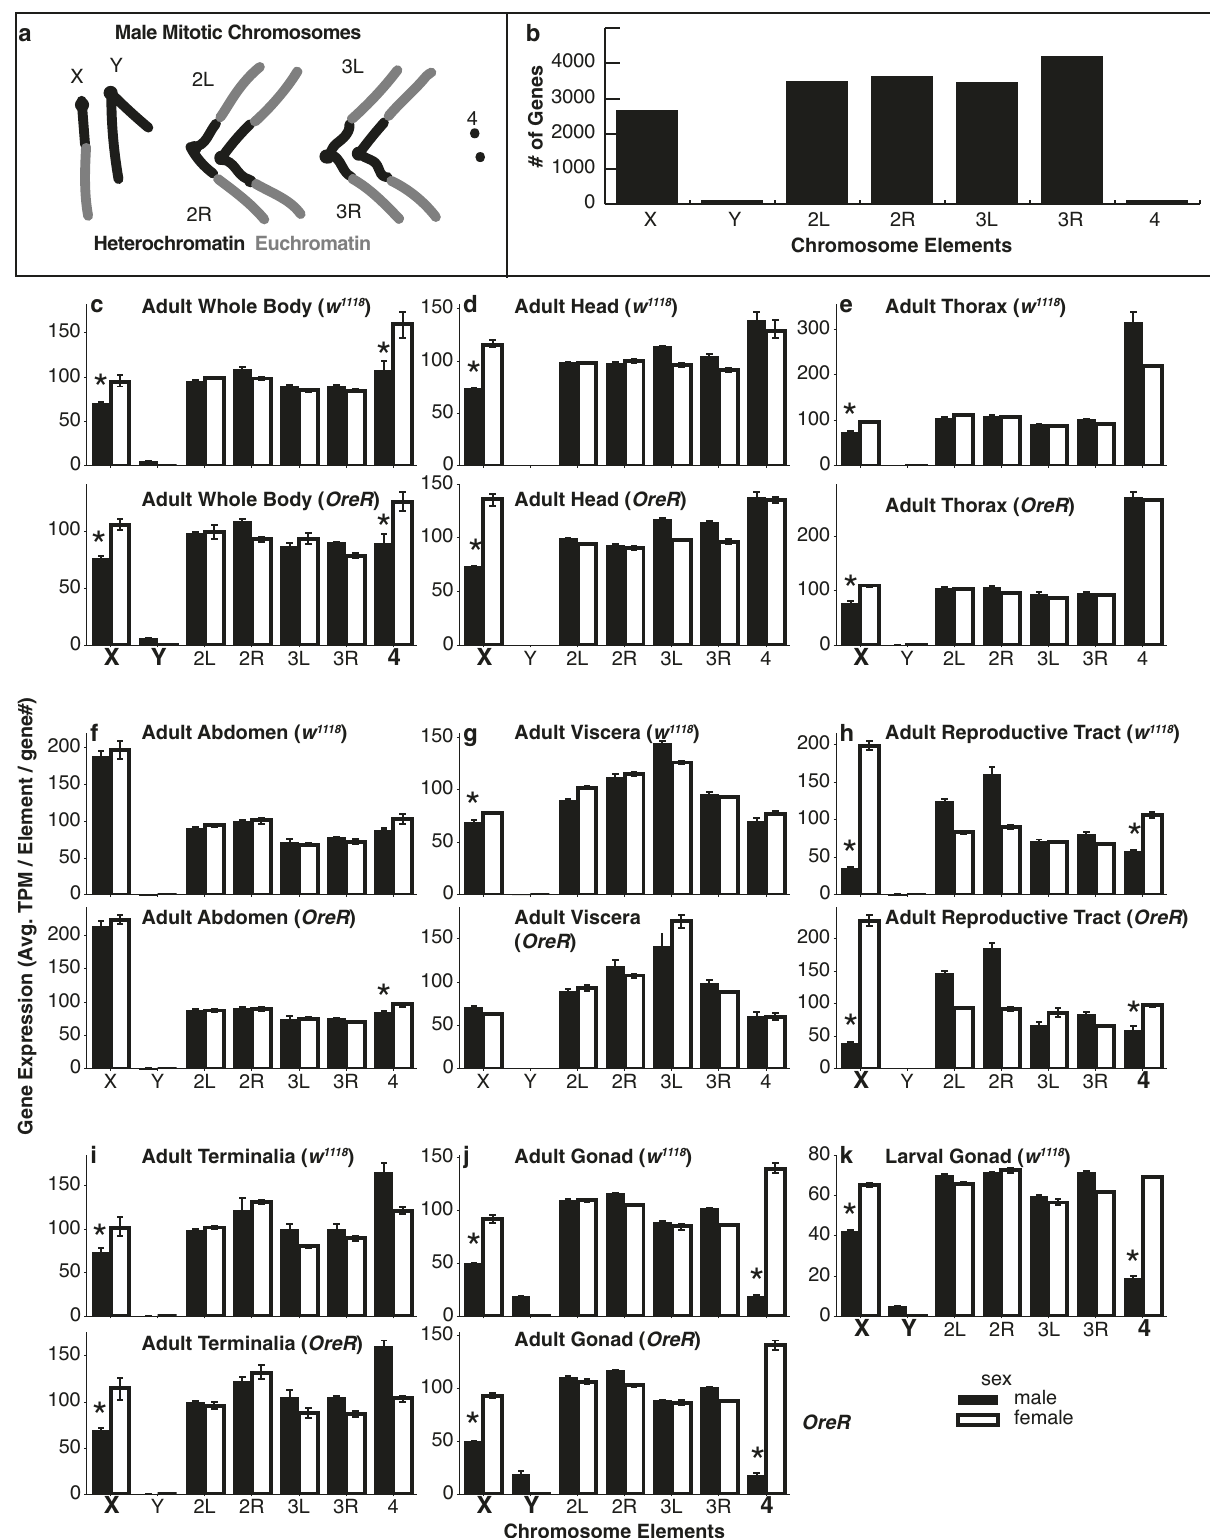
Chromosome Elements Given the dynamic expression of the sex chromosomes by males. Because there are two copies of the 4th chromosome genes, tissue, it is reasonable to assume that there could be differences by under-representation of expression cannot be explained by the cell type and stage within the gonad. Examination of X-linked absence of dosage compensation. These data again suggest that gene expression from hand-dissected anterior, middle, and there has been sexual selection of sex chromosomes, but only posterior regions of adult testes shows a dynamic pattern of X gonads show sex-biased expression of the Drosophila X, Y, and chromosome expression that decreases as germ cells mature 25 . 4th chromosomes. NATURE COMMUNICATIONS| (2021) 12:892